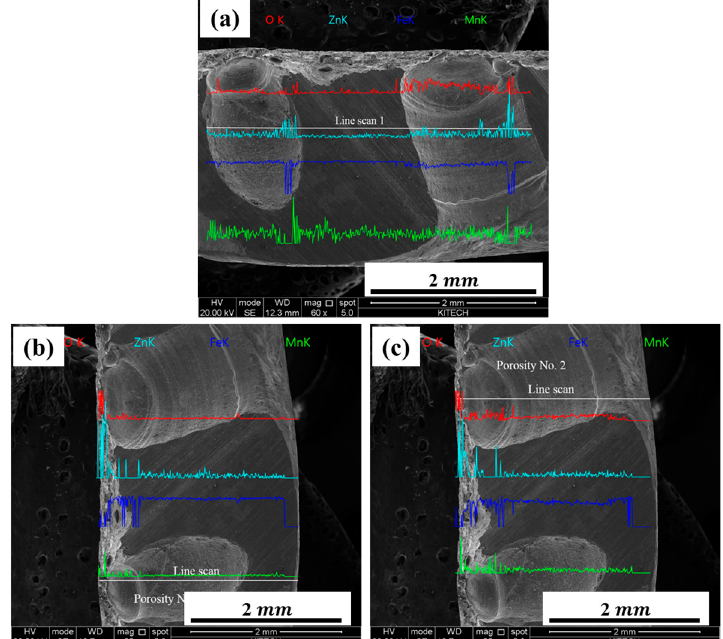
Figure 7. Energy dispersive X-ray spectroscopy (EDS) line scan analysis of porous locations in the welded section: ( a ) horizontal line scan image for pores 1 and 2 from the welded cross section; vertical line scan images for ( b ) pore 1 and ( c ) pore 2.